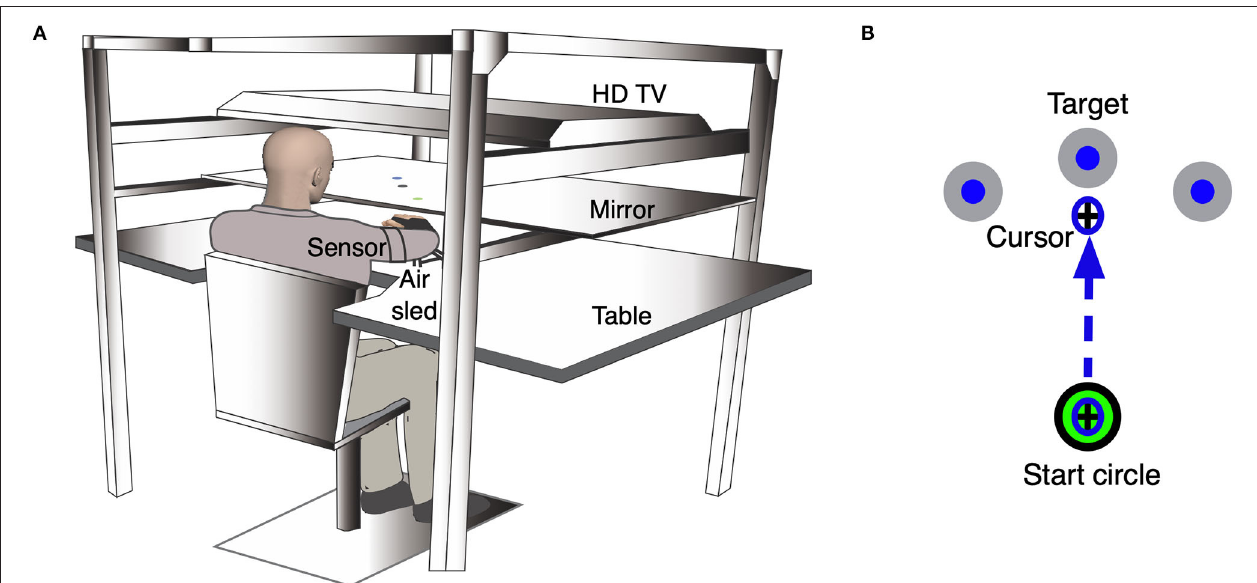
FIGURE 1 | Experimental setup for the kinematic task. (A) An illustration of the KineReach setup. Participants are seated in front of a table with the chin resting on a mirrored surface that displayed the task and occluded view of the hands. Sensors were placed on the ipsilesional hand and upper arm. The hand was supported on an air sled. (B) Schematic of the ipsilesional arm reaching task showing movement of a cursor to the middle target. Participants were asked to move the cursor (representing the position of the hand) quickly into a target that appeared in one of three directions in a pseudorandom manner. The task consisted of 99